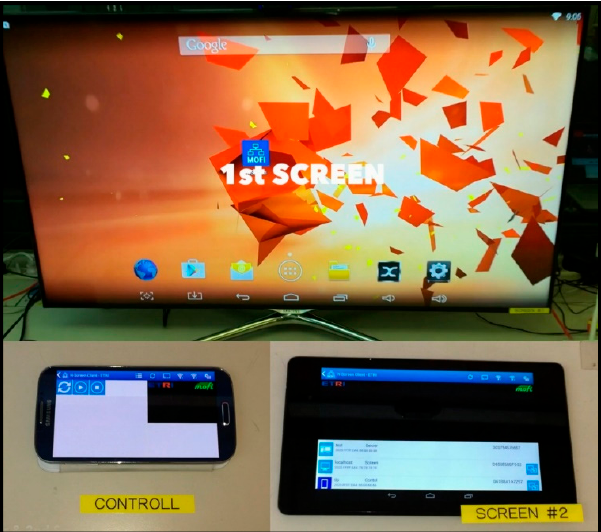
Figure 31. Testbed snapshot for the N ‐ Screen scenario. Electronics 2019 , 8 , x FOR PEER REVIEW 22 of 24